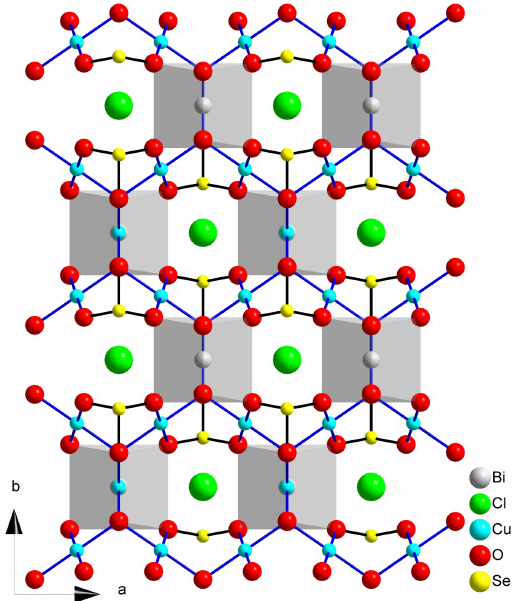
Figure 14. The crystal structure of Cu 3 Bi(SeO 3 ) 2 Cl. [BiO 8 ] distorted cubes are